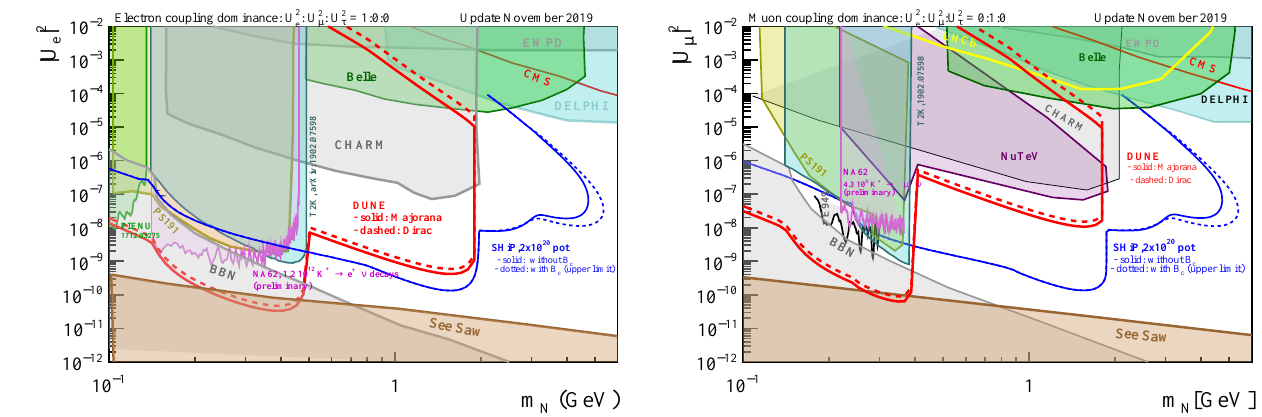
2 and 2 are presented for DUNE ND (red). U eN U µ N | | | |